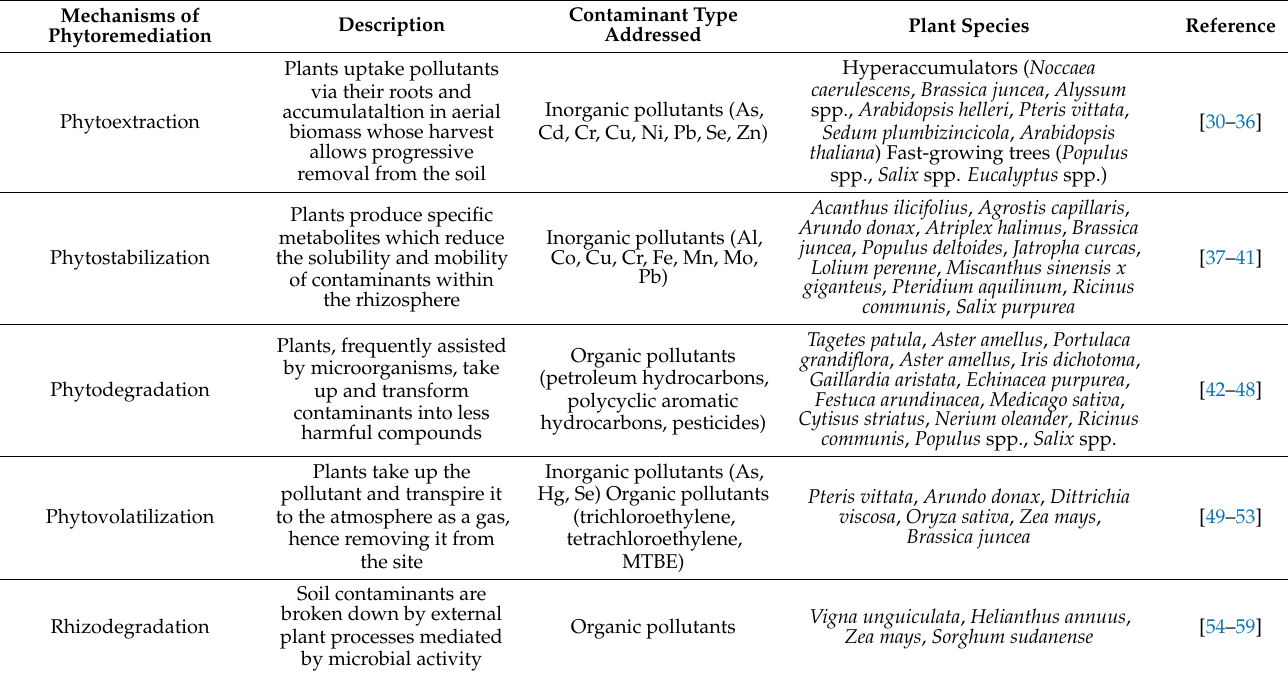
Table 1. The most common phytoremediation